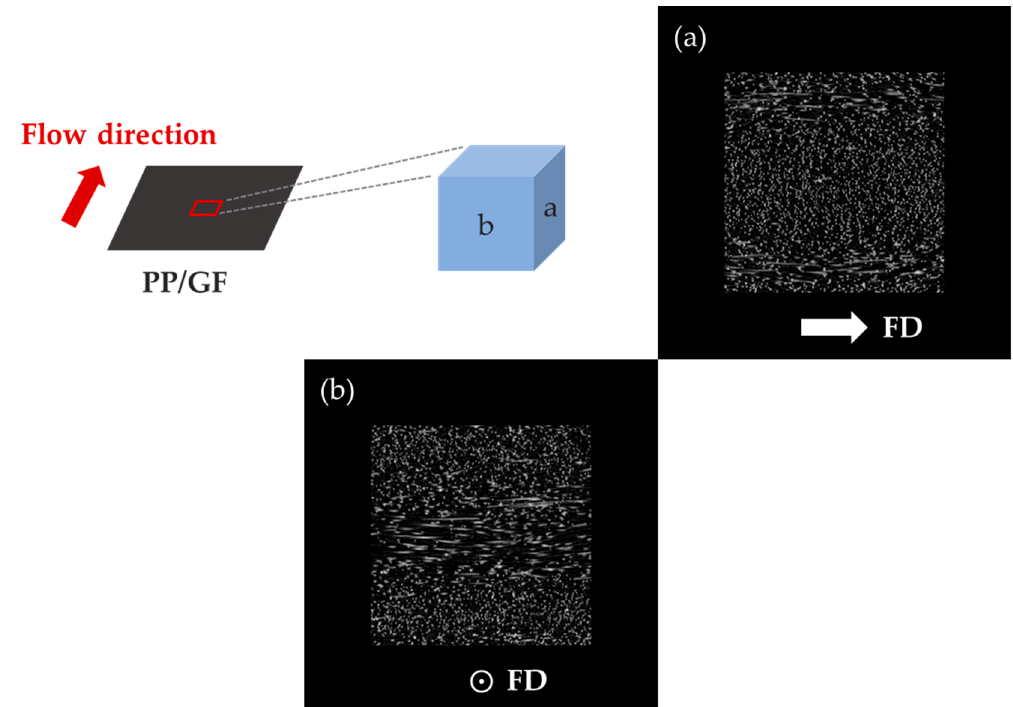
Figure 12. Distribution of glass fibers (GF) in PP measured by Micro-CT: ( a ) side and ( b ) front.